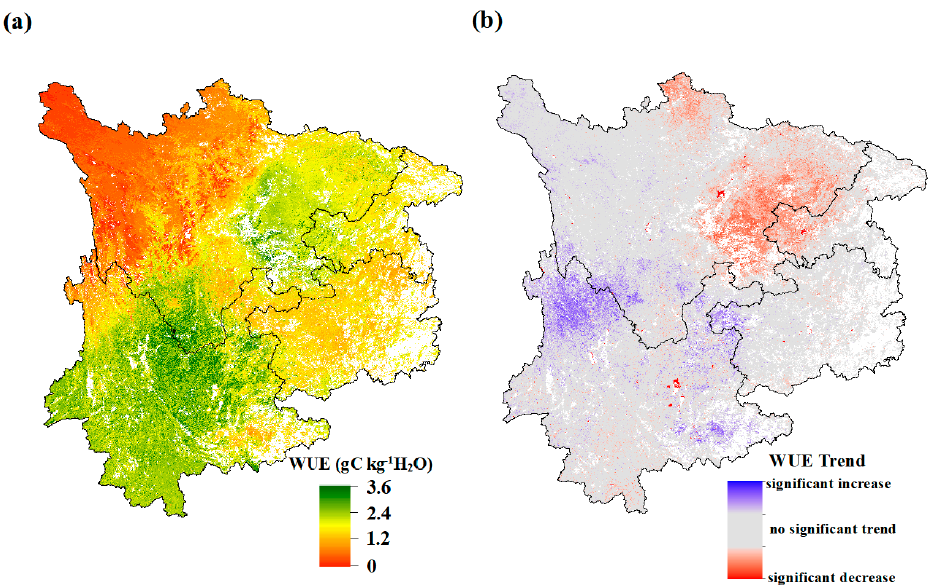
Figure 5. The mean annual WUE and the trend in annual WUE over Southwest China from 2000 to 2017: ( a ) mean annual WUE; ( b ) trend of annual WUE.